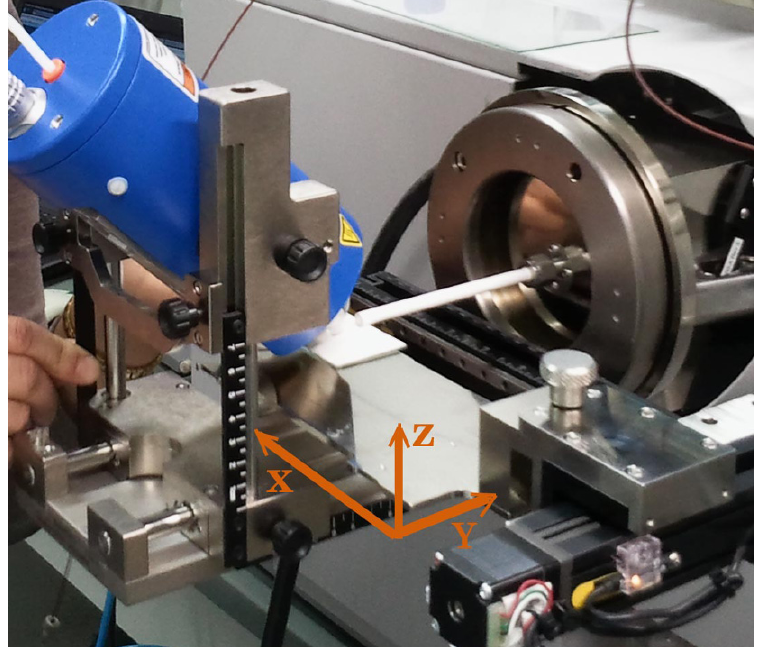
Figure 4. Scanning analysis of surfaces by DART-MS using the newest generation of DART ion source models with the desorption at an angle option and the x - y - z -table. Introduction of a whole TLC/HPTLC plate into the DART-MS ionization region (reproduced from [15], with permission of ‘Elsevier’)